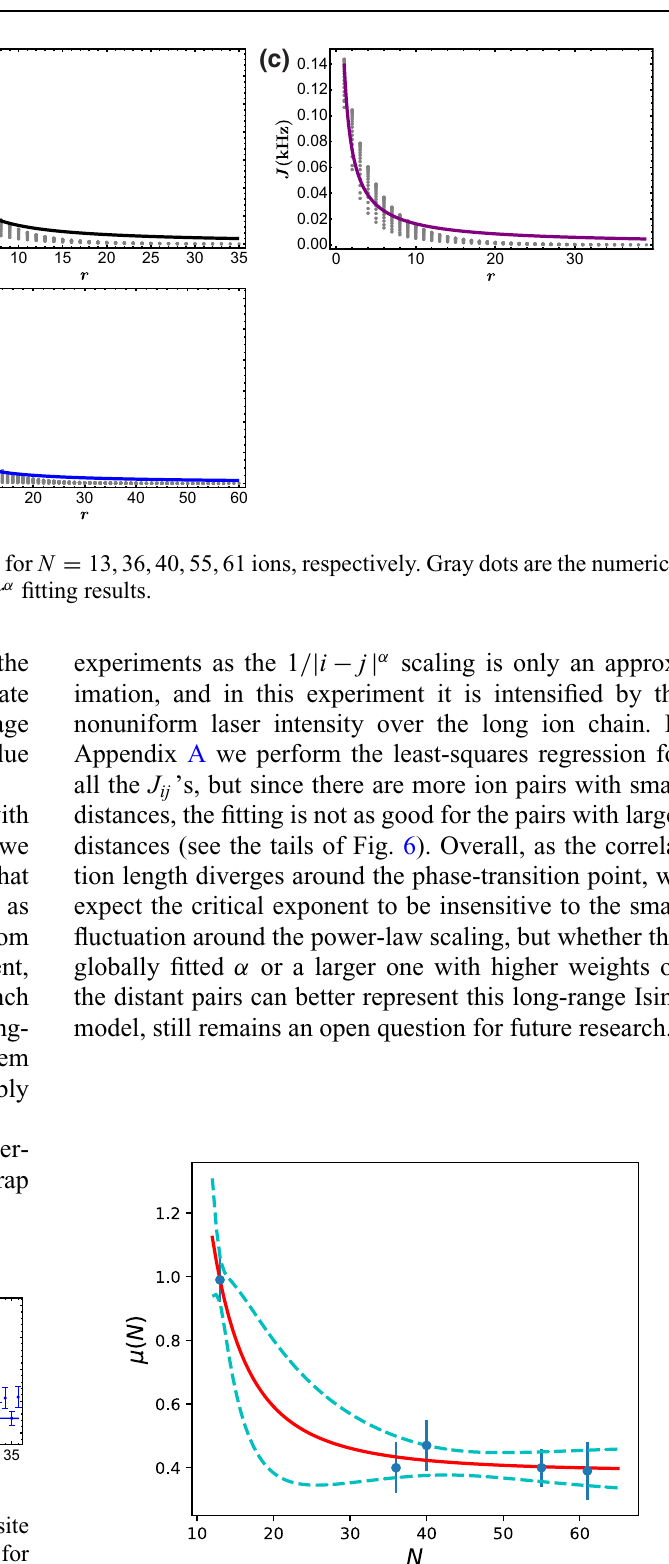
FIG. 8. Fitting μ( N ) with μ ∞ + aN − b . The best fit is given by μ ∞ = 0.39 ± 0.11, a = ( 0.4 ± 2.9 ) × 10 3 , b = 2.5 ± 3.1 as the red curve. The upper and lower dashed curves represent one standard